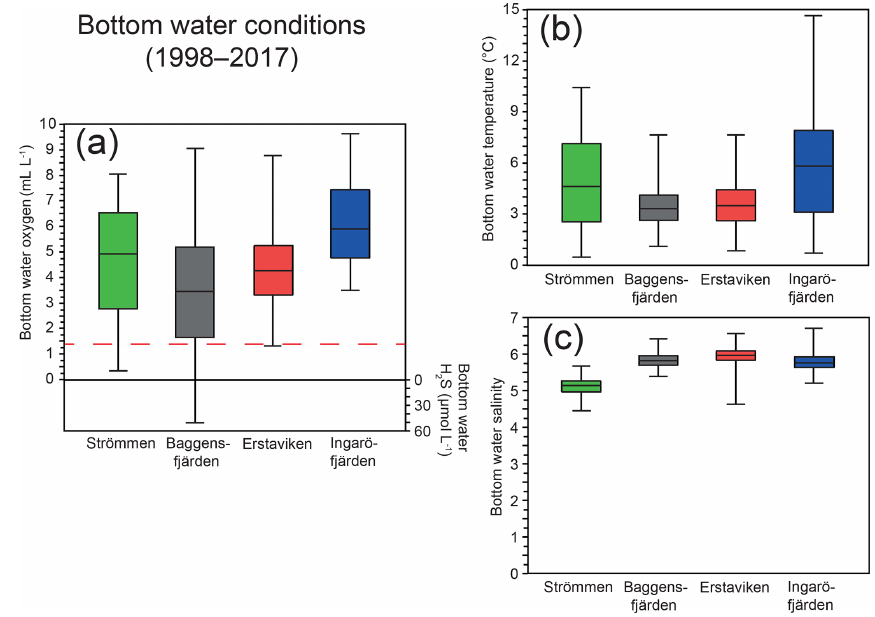
Figure 2. Ranges in bottom water oxygen and sulfide (a) , temperature (b) and salinity (c) over the last 20 years (1998–2017) at water quality monitoring stations (SMHI, 2019; Fig. 1) most proximate to the study sites. The solid line between the boxes is the median, and the boxes represent the second and third quartiles. The error bars indicate the minimum and maximum value recorded for the displayed period. The dashed red line (located at 1.4mL L − 1 ; Fig. 2a) indicates the hypoxic